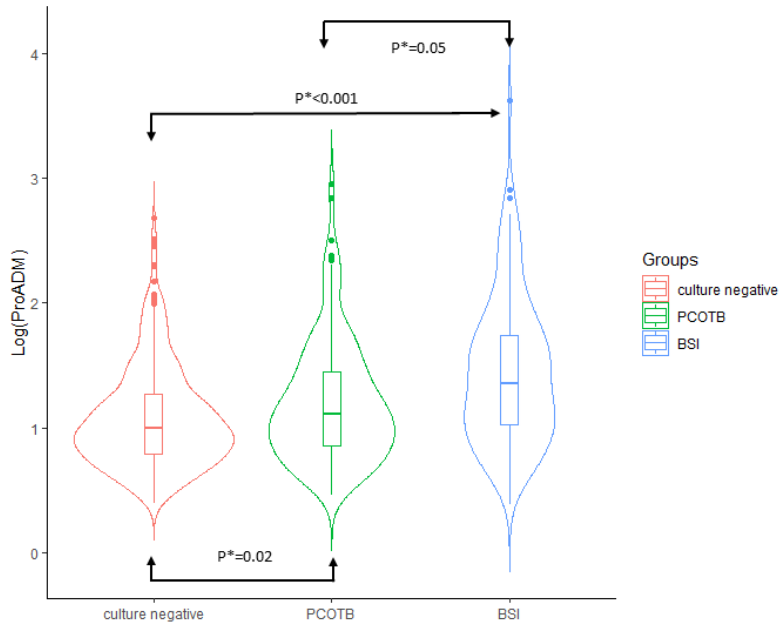
Figure 3. Correlation between median MR-proADM concentrations and the three cultural statuses (violin plot): culture-negative sepsis, sepsis with positive cultures other than blood (PCOTB), and bloodstream infections (BSI).